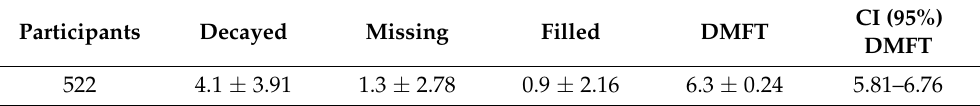
Table 10. Average number of decayed, missing, and filled teeth in permanent dentition (DMFT).